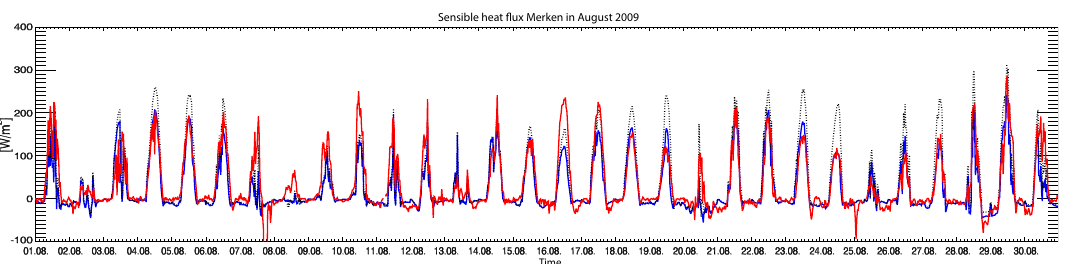
Figure 7. Soil moisture in Merken in August 2009 at 3cm depth. The red dotted line displays values of a further instrument (see text). Otherwise, colours are as in Fig. 5.